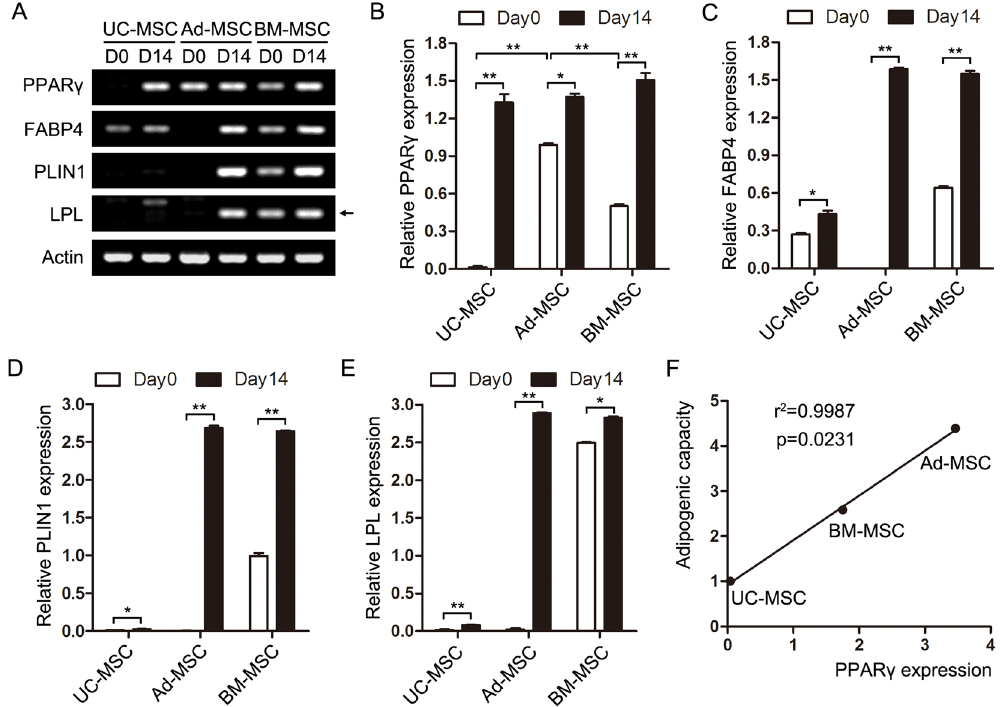
Figure 4. Comparison of adipogenic gene expression in the three tissues-derived MSCs by RT-PCR. UC- MSC, Ad-MSC and BM-MSC were incubated with or without adipogenic medium for 14 days. ( A ) Adipogenic markers including PPAR γ , FABP4, PLIN1 and LPL were detected at the indicated days of differentiation. Actin was used as a loading control. The picture was cropped and adjusted using photoshop software and the original image was presented in Supplementary Fig. 1. ( B – E ) The quantification of the four marker genes was performed using Gel-Pro software and presented. ( F ) The correlation of adipogenic capacity with PPAR γ expression in the three sources-derived MSCs was performed using linear regression analysis. * P < 0.05 and ** P < 0.01, Student’s